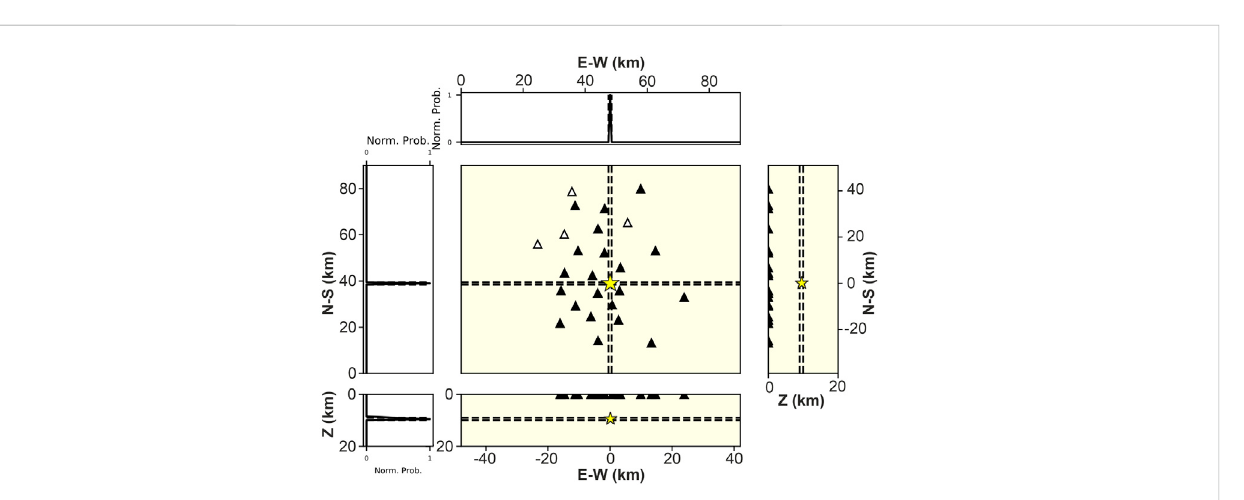
FIGURE 5 Example of probabilistic earthquake location for the M v 2.5 earthquake which occurred on 16/05/2011 at 13:25:04 (JST) in the Nagano region. The earthquake location in the horizontal and vertical planes, with uncertainties (dotted lines), is marked by a yellow star. The normalized probability density function is shown along N-S and E-W directions and along a vertical